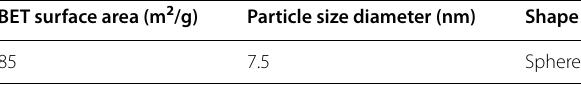
O catalyst Table 4 Effect of reaction temperature on 2 4